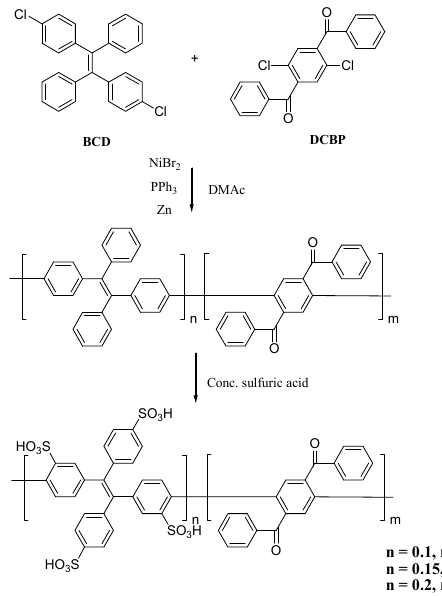
Scheme 1. Synthesis of BCDCBP and SBCDCBP.